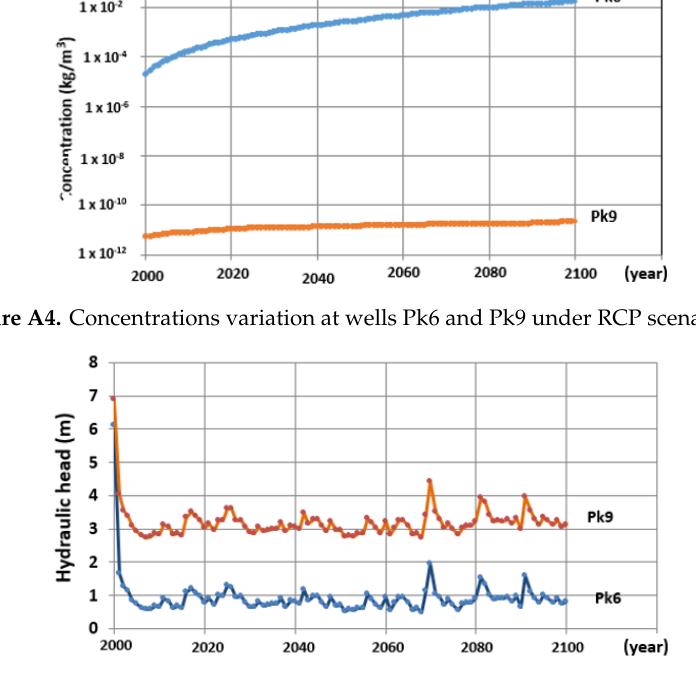
Figure A5. Piezometric variations at wells Pk9 and Pk6 from 2001 to 2100 under scenario RCP 4.5.